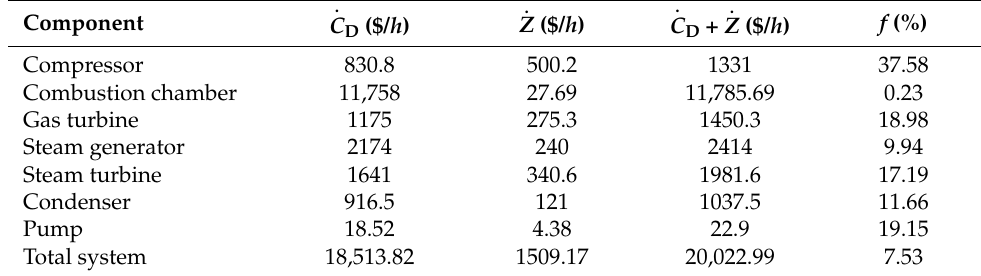
Table 12. Exergoeconomic analysis of Config. 1.